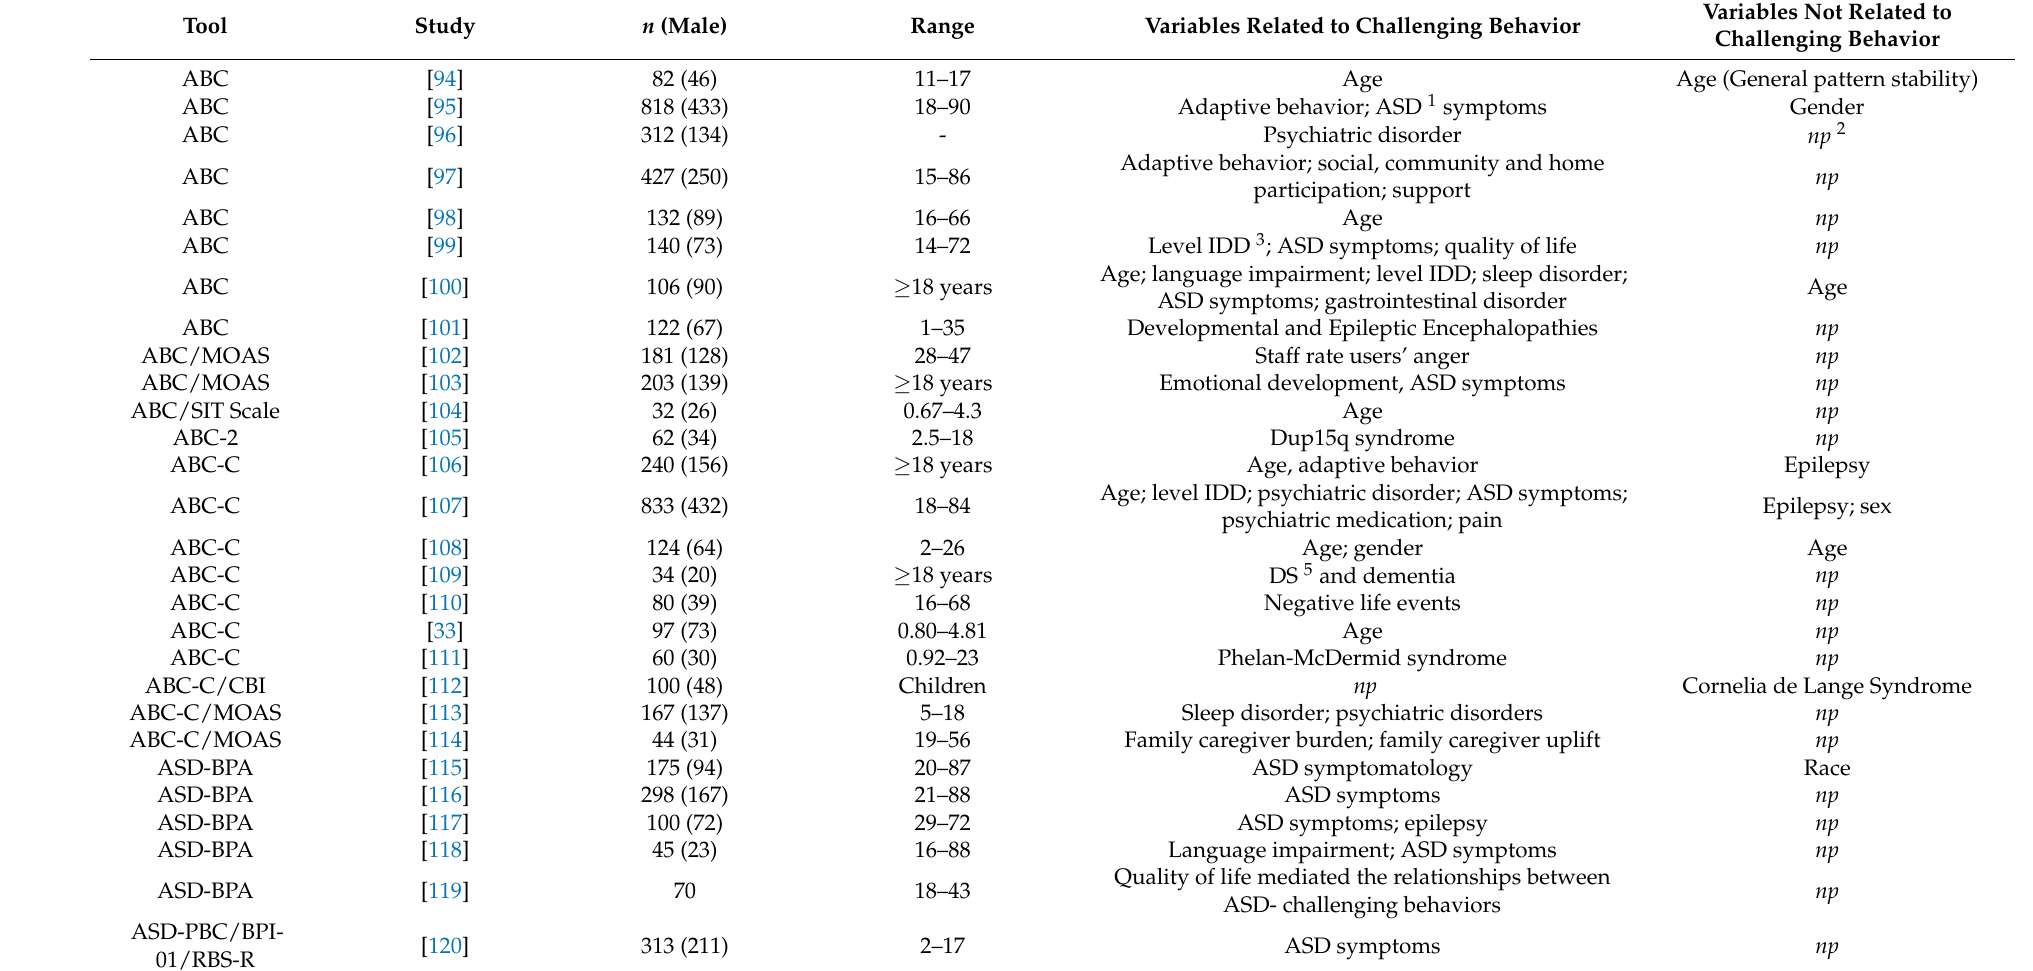
Table 3. Relational studies using the instruments identified in the